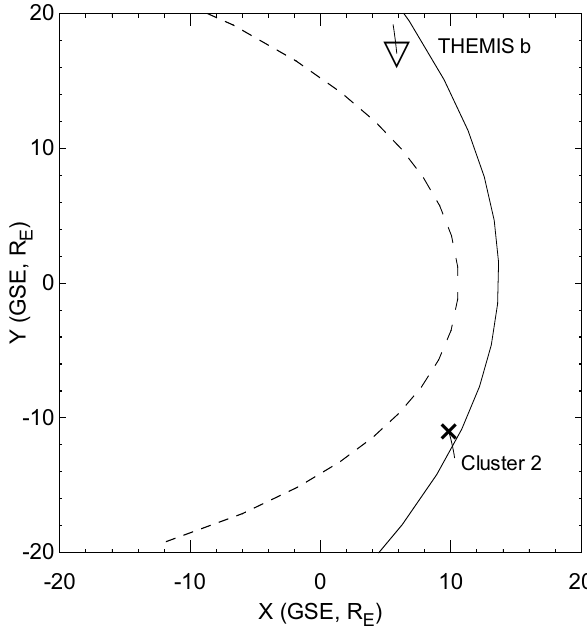
Fig. 2. Spacecraft trajectories: THEMIS b (Triangle) and Clus- ter 3 (cross) from 20:30 to 23:00UT, 4 May 2008, along with nom- inal bowshock (solid) and magnetopause (dashed) locations. At 21:10UT the spacecraft were located at ( 9 . 8 , − 10 . 9 , 0 . 050 ) GSE R E and ( 5 . 9 , 16 . 8 , − 7 . 3 ) GSE R E ,